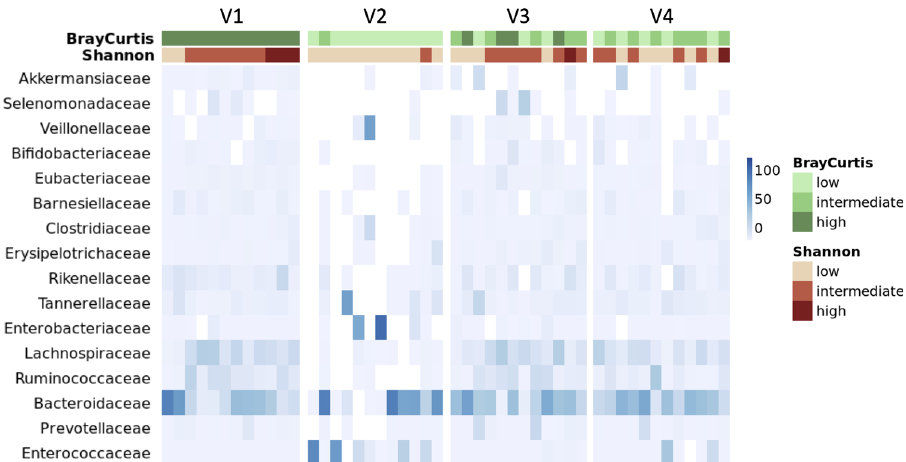
Fig. 3 Family pro fi le heatmap. The relative abundances of the families found in the different samples are represented in shades of blue. Each column corresponds to a patient and the order of the columns is respected between the different panels. Only patients for which a complete kinetics from visit 1 (V1) to visit 4 (V4) is available are shown ( n = 12). For each sample, the associated values of the Shannon index at the species level and the Bray-Curtis similarity with respect to V1 at the species level are represented. For Shannon index, ranges were based on the Shannon value of the study population: low < fi rst quartile, medium ≥ fi rst quartile and < third quartile, high ≥ third quartile. For Bray – Curtis similarity index: low < 0.4, medium ≥ 0.4 and < 0.6 and high ≥ 0.6. The choice of this mathematically determination was made before the analysis of the by high-dose cytarabine based consolidation chemotherapy, with no signi fi cant reduction of α -diversity indexes and a slight reduction of gene richness compared to V3 (median Shannon: V3 after AFMT (Supplementary Fig. 4).